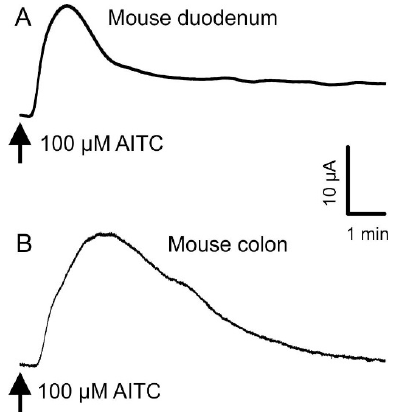
Figure 2. Representative traces of the short circuit current ( I sc ) following addition of AITC (100 μ M). AITC was added to the mucosal side of the Ussing chamber mounted with wild ‐ type mouse duodenum ( A ) and distal colon ( B ).